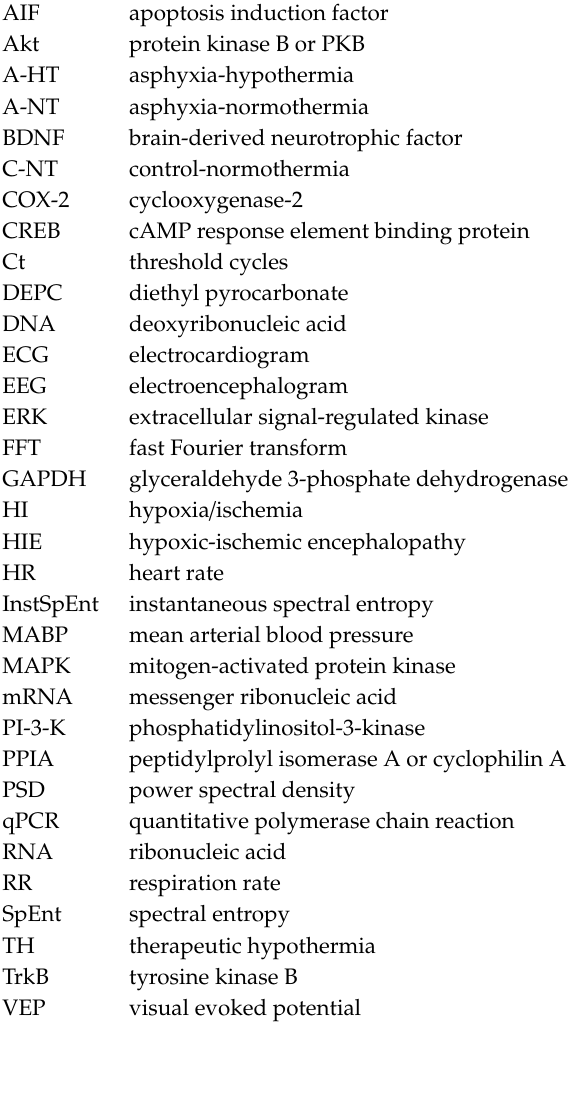
Table S1: Amplitude-based EEG scoring system, Table S2: Average power spectral density values, Figures S1–S6: Representative photomicrographs from the hippocampus CA1, hippocampus CA3, caudate nucleus, putamen, thalamus and neocortex,